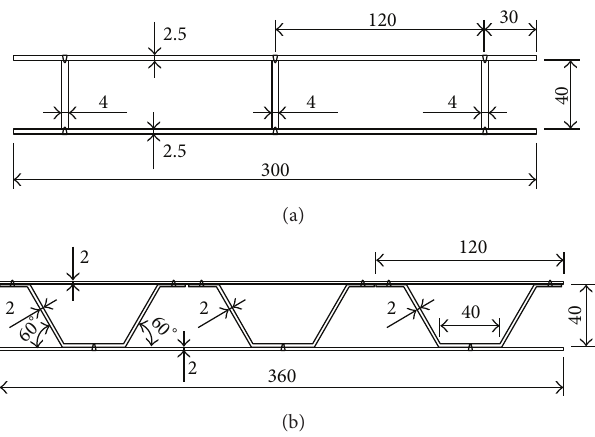
Figure 5: The cross-sectional dimensions for web-core sandwich beam (a) and corrugated core sandwich beam (b)